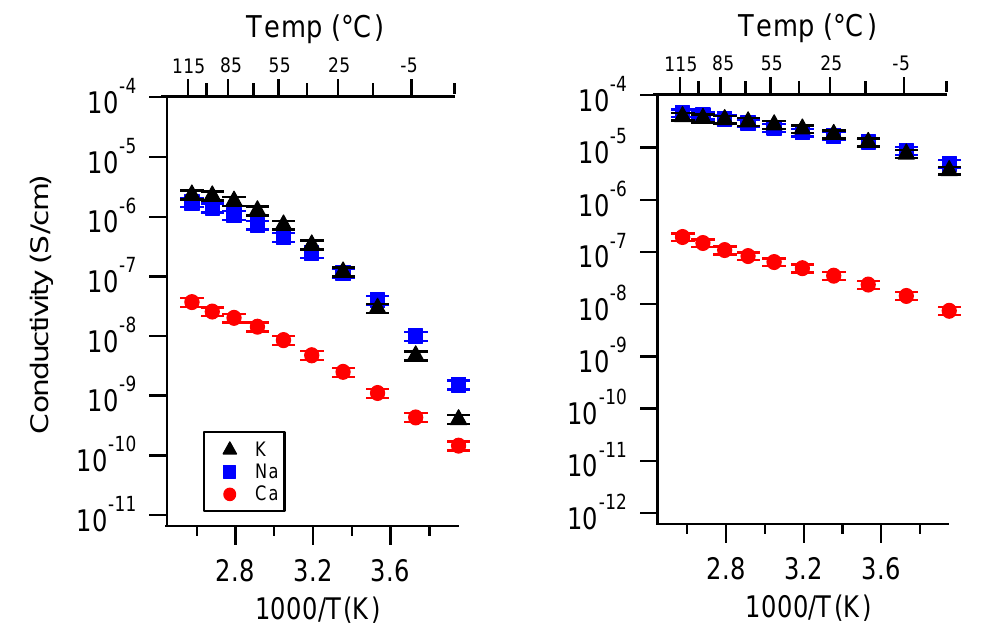
Figure A1. (reproduced from main text) Conductivity as a function of cation for PEGDMA1000_low_SSM (left) and PTHFDA1000_low_STFSI (right) SIPEs swelled with DEG. Temperatures ranged from − 20 °C to 115 °C.